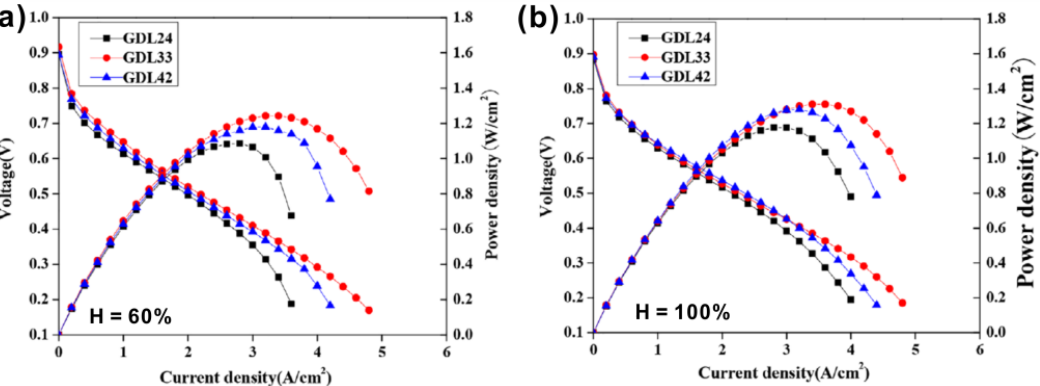
Figure 10. I – V curves and power densities of PEMFCs using GDLs containing bilayer MPLs with a controlled thickness for each MPL. The test was performed under the relative humidity of ( a ) 60% and ( b ) 100%. Reproduced with permission [96]. Copyright 2020, John Wiley and Sons.